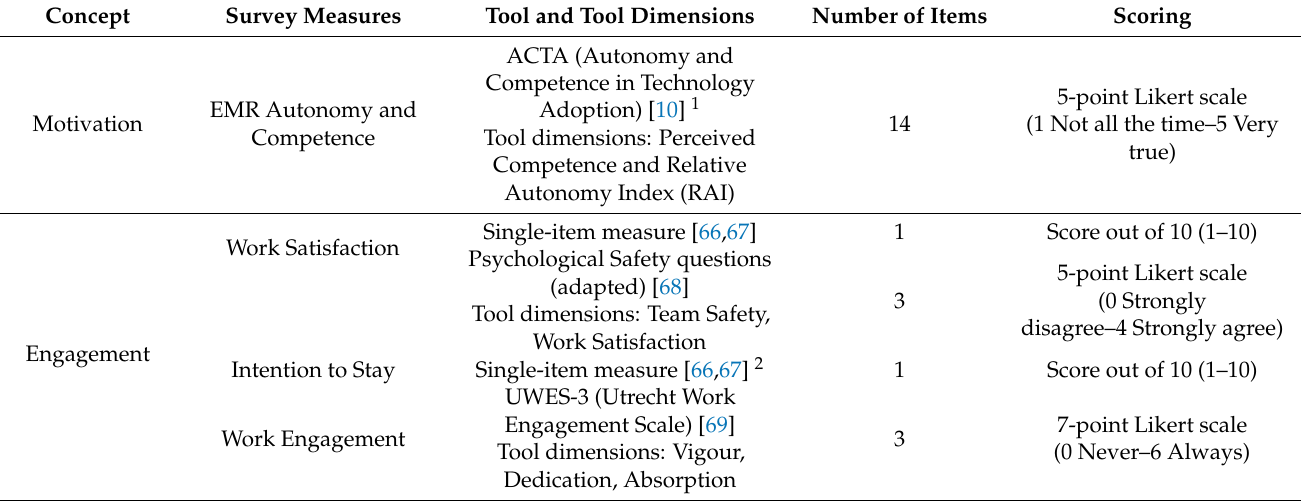
Table 1. Survey Measures, tools used, number of items and